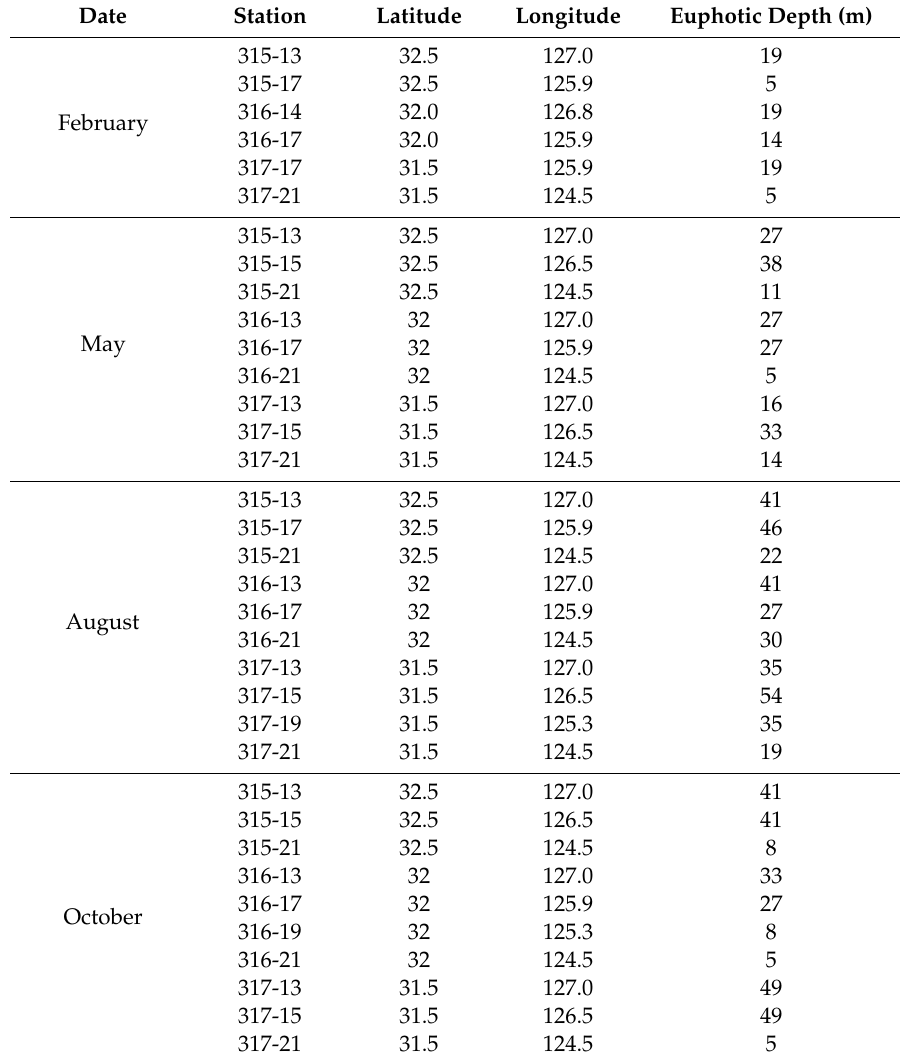
Figure 1. Sampling stations in the northern East China Sea, 2018. The major currents in the northern East China Sea are based on [19]. Table 1. Description of sampling stations in the northern East China Sea for each cruise period, 2018.